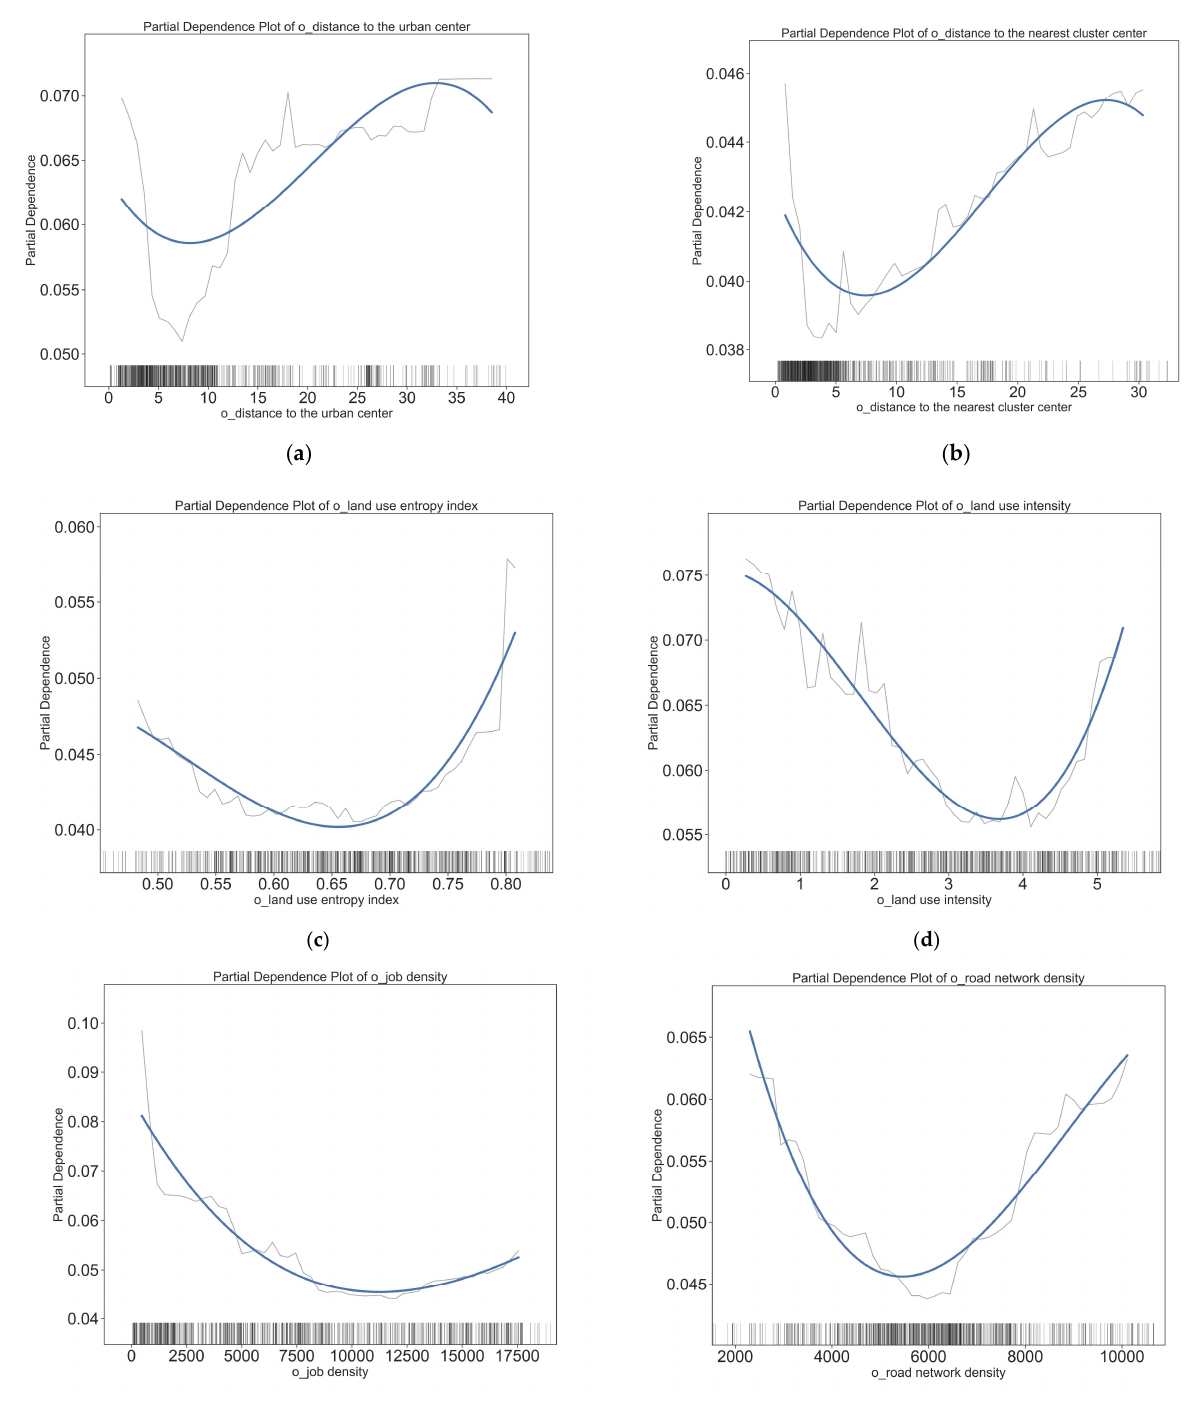
Figure 5. The effects of residential (O point) built environment variables on the choice to cycle. ( a ) Impact of distance to the urban center on cycling choices; ( b ) impact of distance to the nearest cluster center on cycling choices; ( c ) impact of land use entropy index on cycling choices; ( d ) impact of land use intensity on cycling choices; ( e ) impact of job density on cycling choices; ( f ) impact of road network density on cycling choices.